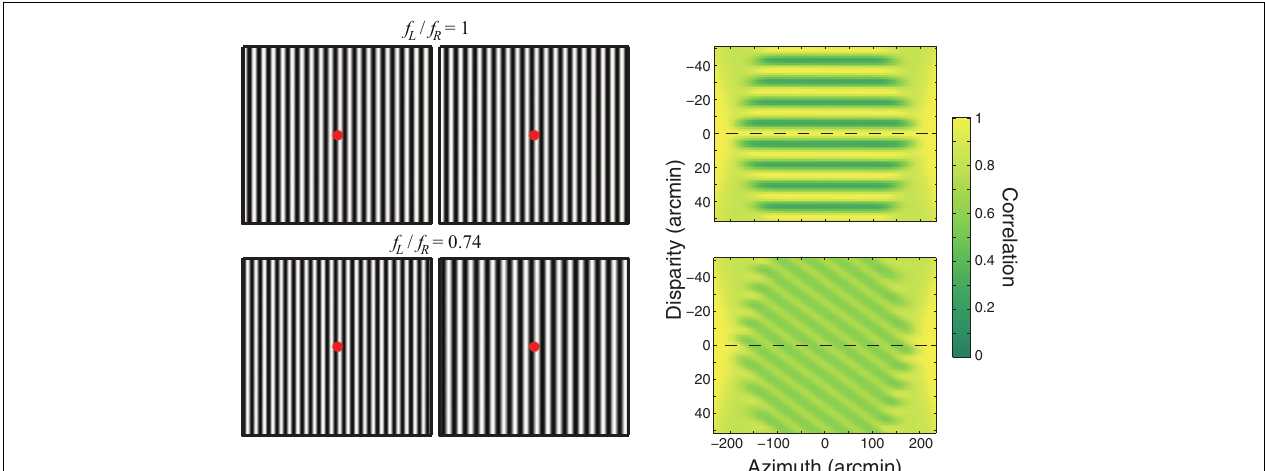
FIGURE 1 | Wallpaper illusion and Venetian-blind effect. Left: The upper part shows the Wallpaper illusion. Vertical sinewave gratings of the same spatial frequency and contrast are presented to the two eyes (ratio of spatial frequencies f L / f R = 1). Cross-fuse such that the red dots superimpose. One sees a single plane of vertical stripes at the depth of the fused red dot. The lower part shows the Venetian-blind effect. Vertical sinewave gratings of different spatial frequencies are presented to the two eyes ( f L / f R = 0 . 74). Cross-fuse again such that the red dots superimpose. Holding fixation on the fused red dot, one sees a series of slanted planes: Venetian blinds. If you move your eyes slowly to the left or right, the breaks in the blinds move with the eyes. Right: Local